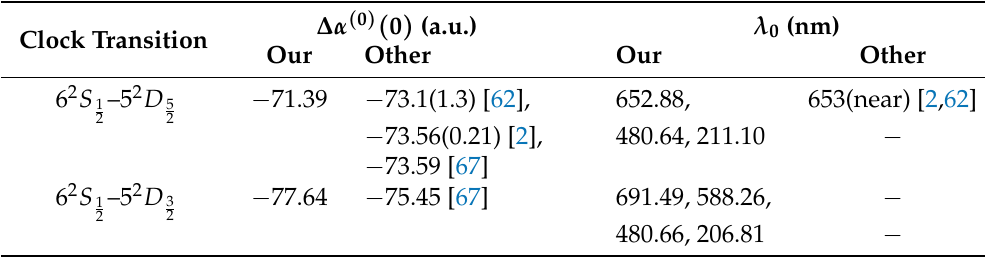
Table 3. Comparisons of our (‘Our’) calculated differential static scalar polarizabilities, i.e., ∆ α ( 0 ) ( 0 ) for the clock transitions with the corresponding other (‘Other’) values as found in the literature. The last two columns highlight the comparison of λ 0 at which ∆ α ( 0 ) ( ω ) = 0.